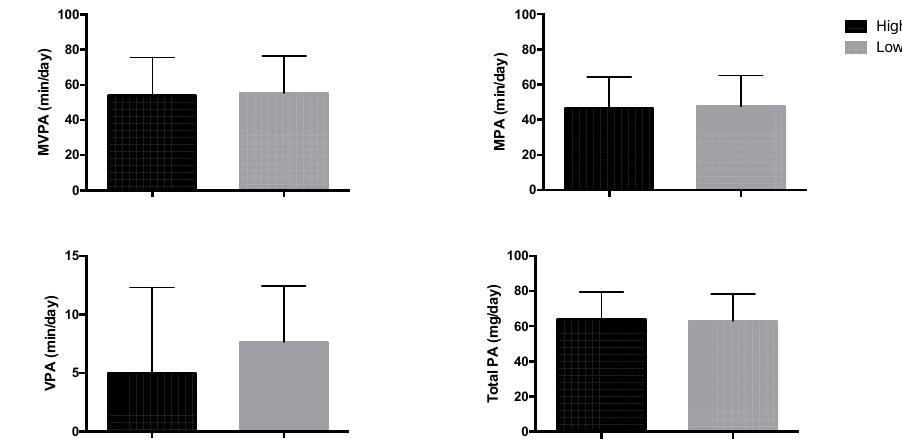
Figure 2. Moderate physical activity (min/day), moderate–vigorous PA (min/day), vigorous PA (min/day), and total PA (mg/day) for the sample divided in high or low adherence to the Mediterranean dietary pattern. Analyses were examined by t -Student tests and no significant differences were found. High adherence to the Mediterranean diet pattern index: MDP index ≥8; Low adherence to the Mediterranean dietary pattern: MDP index <8.